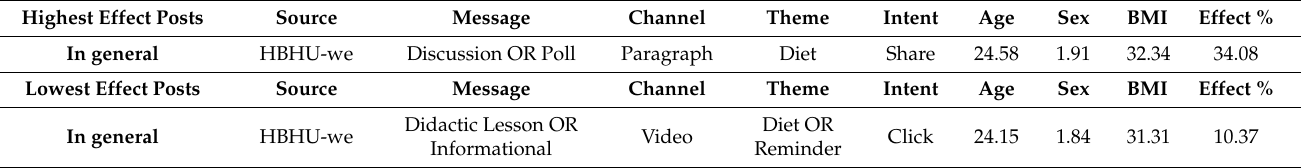
Table 3. Summary of Highest vs. Lowest Effect Posts.